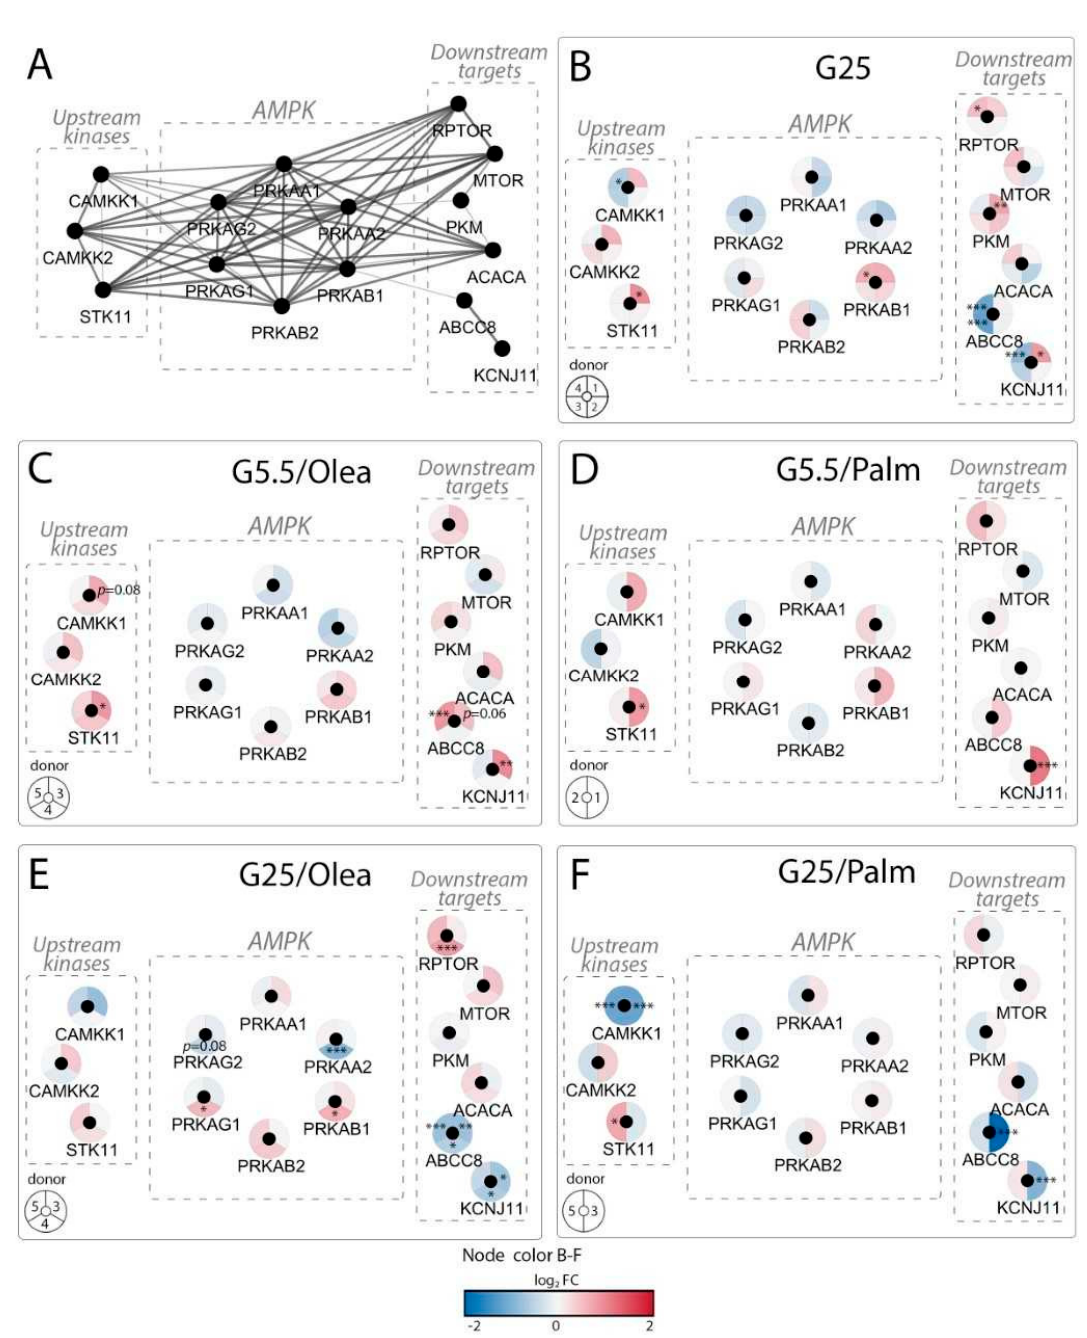
Figure 3. AMPK transcript levels in human islets under metabolic stress conditions. ( A ) Functional interaction network of human AMPK-associated genes, i.e., AMPK subunits (AMPK box), upstream kinases, and downstream targets. ( B – F ) Effects of culture conditions compared to standard G5.5 medium on transcript levels shown as up-regulated (red), down-regulated (blue), or unchanged (white). Each disk is split into individual changes for the different donors. ( B ) Genes regulated upon high-glucose conditions (G25). ( C–D ) Genes regulated upon ( C ) oleate or ( D ) palmitate exposure (0.4 mM) in control glucose condition (G5.5). ( E–F) Genes regulated upon ( E ) oleate or ( F ) palmitate exposure (0.4 mM) in high-glucose conditions (G25). ( A ) Node connections were established according to the STRING interaction knowledgebase with a confidence score >0.4. Color code reflects the changes in expression in log2 fold changes (log2 FC; quantitative data in Supplementary Table S1) of that particular gene for each individual human donor (described in Table S2). Dashed boxes show, from left to right, the upstream kinases comprising CAMKK (calcium/calmodulin-dependent protein kinase kinase) and STK11 (serine/threonine kinase 11/LKB1); the six subunits of AMPK; the